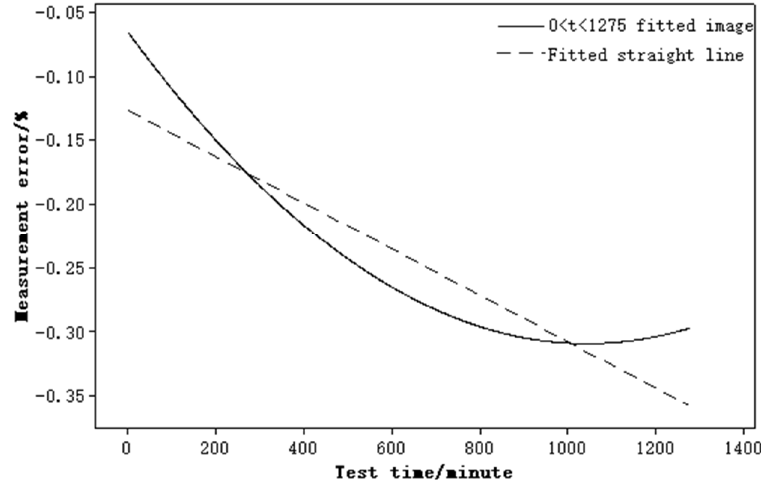
Figure 5. Measurement error growth model before time size transformation.